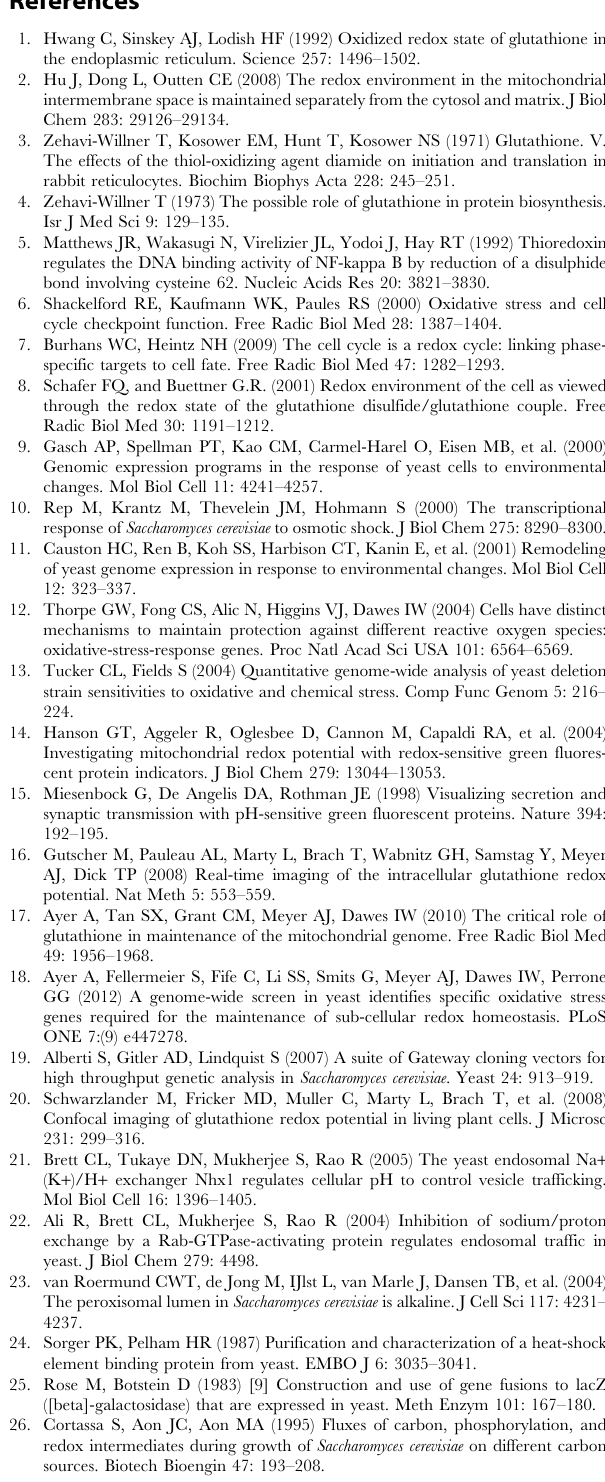
Table S1 Supplements for synthetic complete (SC) medium. Table S2 Primers used in generation of mitochondrial matrix and peroxisomal targeted pHluorin